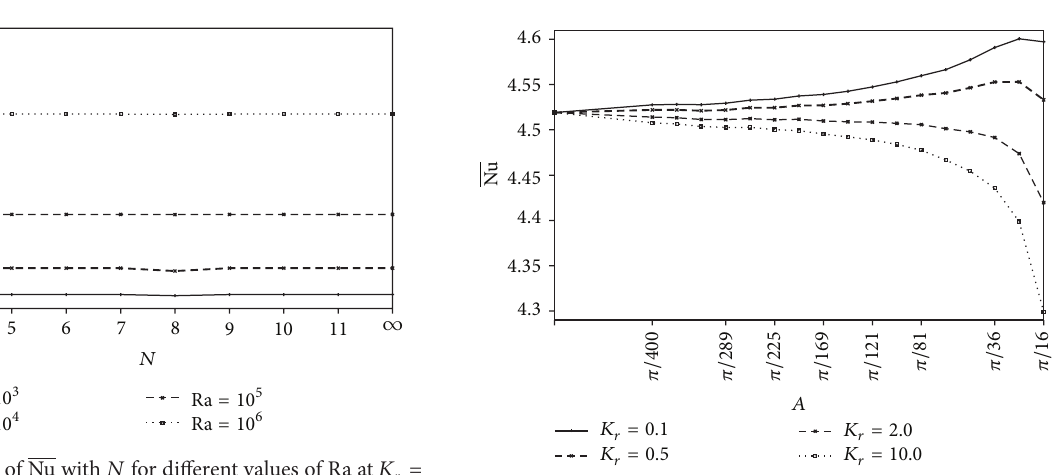
Figure 10: Variation of Nu with 𝐴 for different values of 𝐾 𝑟 at Ra = = 0.5 , and 𝑁 = 5 10 5 , 𝑋 0